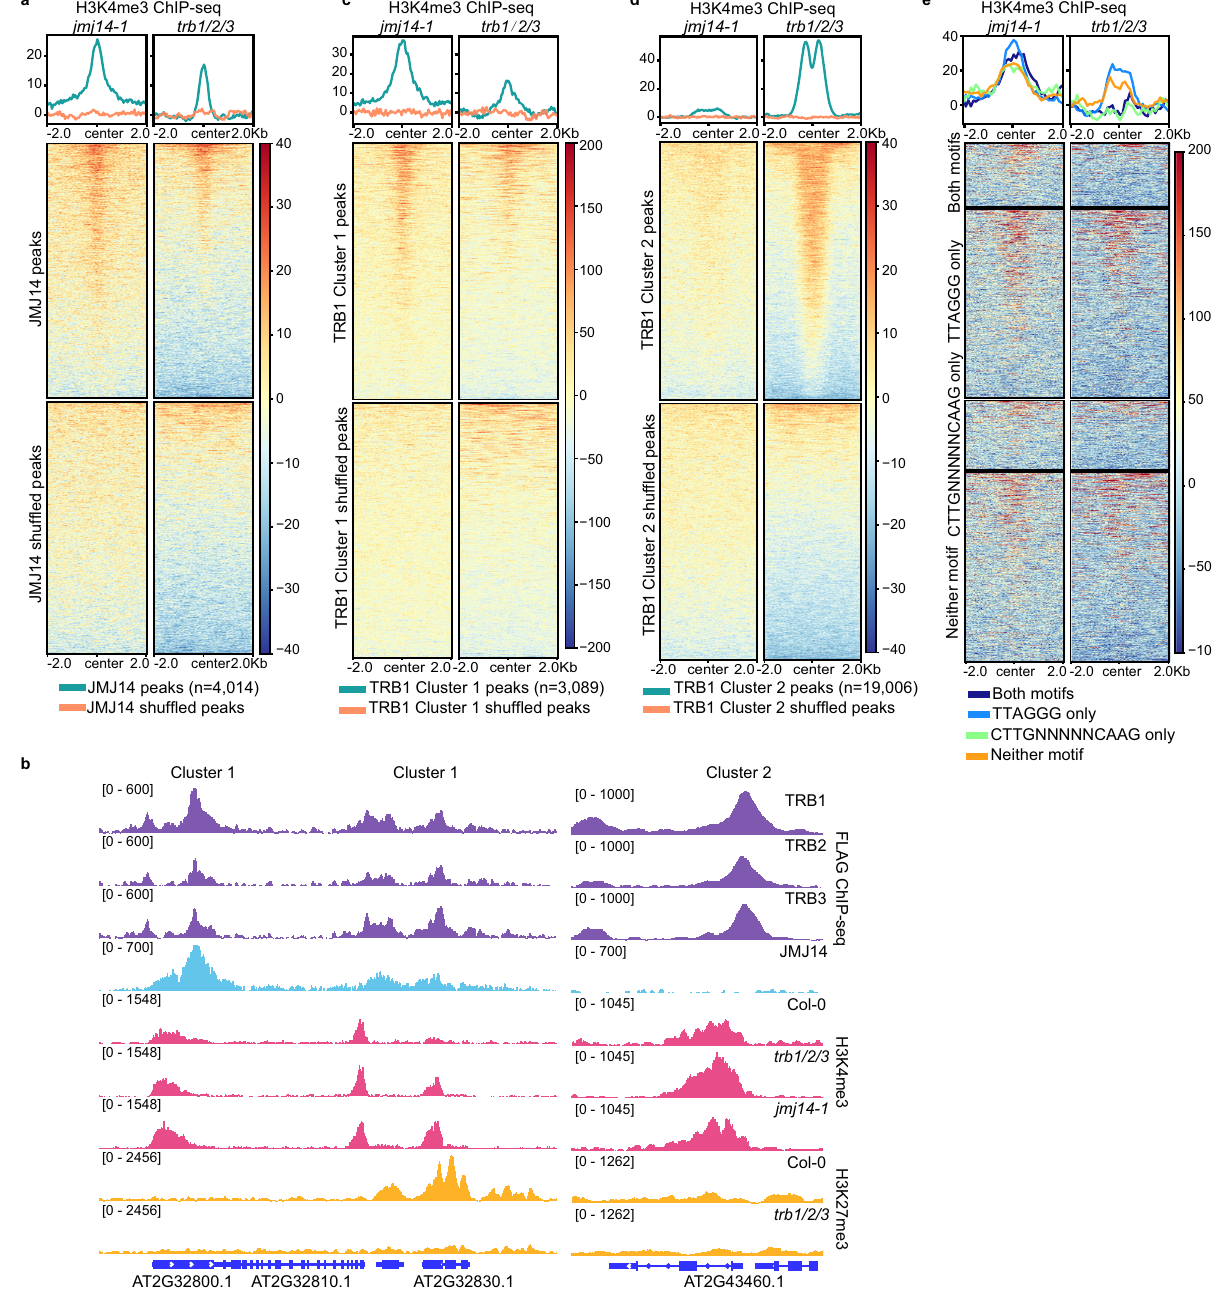
and heatmaps showing H3K4me3 ChIP-seq signals of jmj14-1 and trb1/2/3 mutants versus Col-0 wild type plants over TRB1 Cluster 1 peaks and shuf fl ed peaks ( c , n =3089), TRB1 Cluster 2 peaks and shuf fl ed peaks ( d , n =19,006), and TRB1 JMJ14 co-bound peaks displaying the TTAGGG motif only ( n =1176), the CTTGnnnnnCAAGmotifonly( n =431),bothmotifs( n =396),andneither( n =1180), respectively ( e